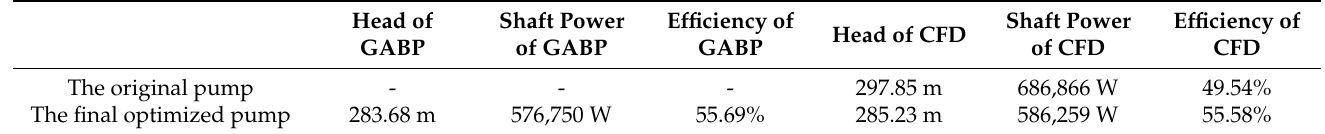
Table 13. Comparison of the hydraulic performance of the original and final optimized pump.